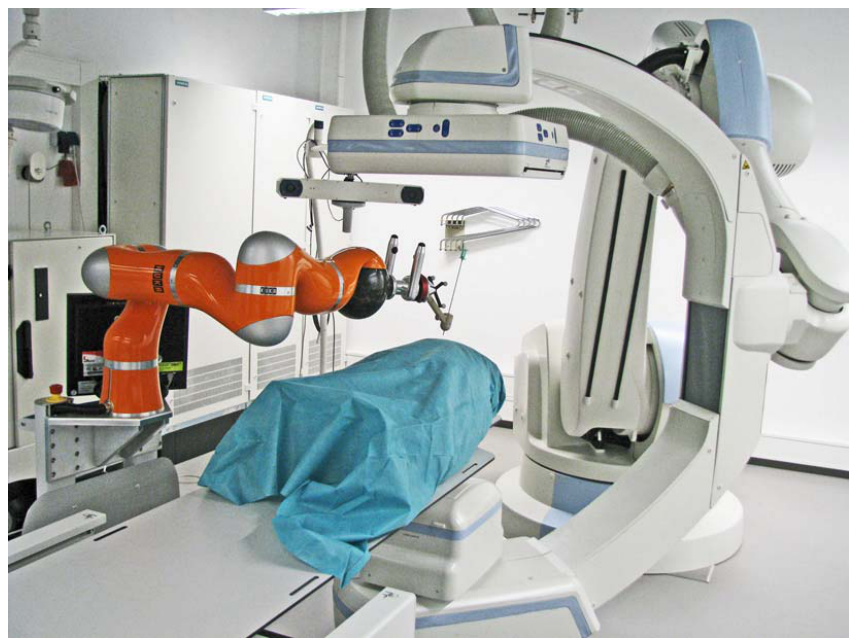
Figure 2. System setup in the interventional